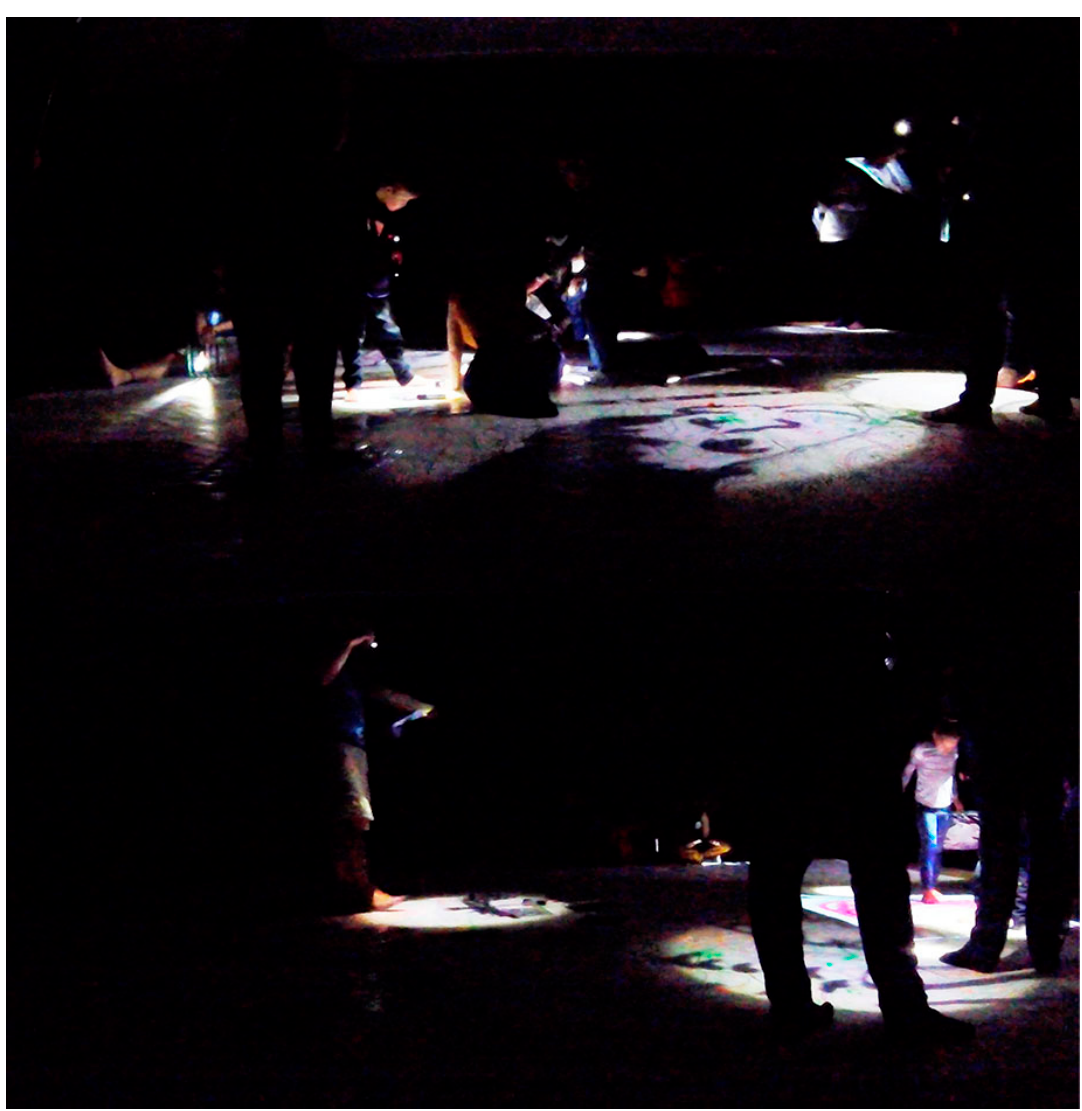
Figure 5. Projected marks: Collective movements with torches and projections.